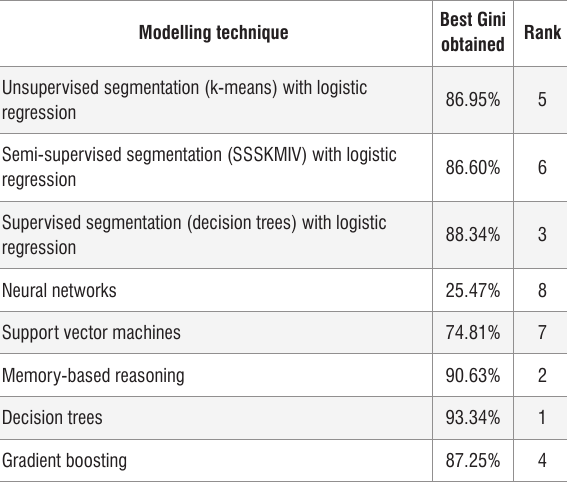
Protein tertiary structures